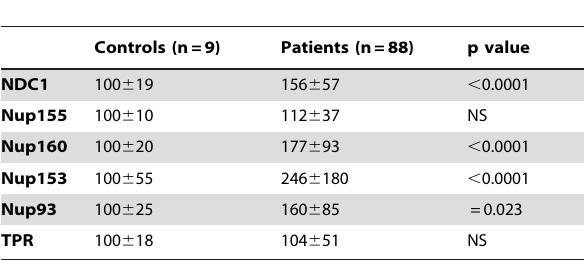
Table 2. Results of the expression of nuclear proteins in HF patients and controls.